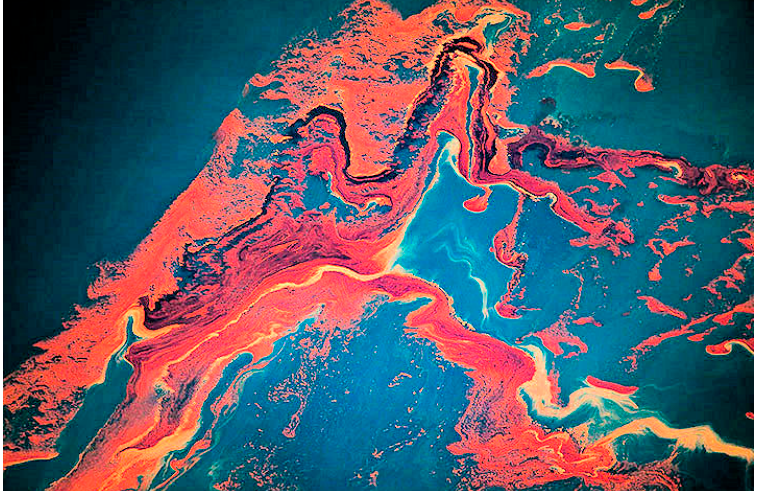
Figure 5. Emulsion shown from an aircraft from an altitude of approximately 100 m.